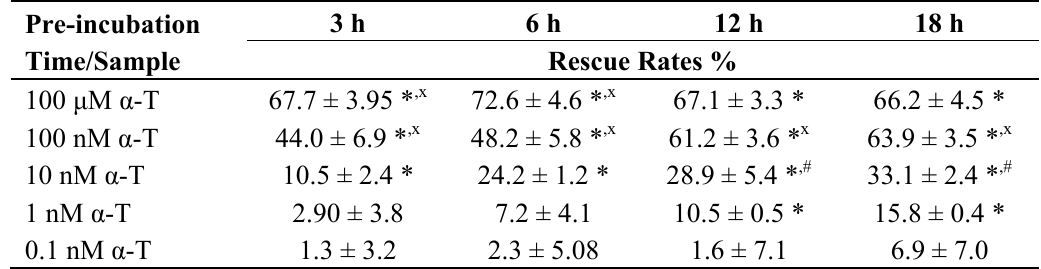
Table 1. The protective effect of α -T against hydrogen peroxide-induced PC12 cell death depends on the time of pre-incubation (rescue rates of α -T, %). The data are means ± SEM from four experiments. PC12 cells were pre-incubated with α -T for 3, 6, 12 or 18 h; then they were exposed to 0.2 mM H O for 24 h. * the protective effect of α -T is 2 2 significant, p < 0.05; x,# the differences are significant as compared to the effect of α -T in all lower concentrations (for the same time of pre-incubation) according to one-way ANOVA followed by Tukey’s multiple comparison test, x p < 0.02, # p <